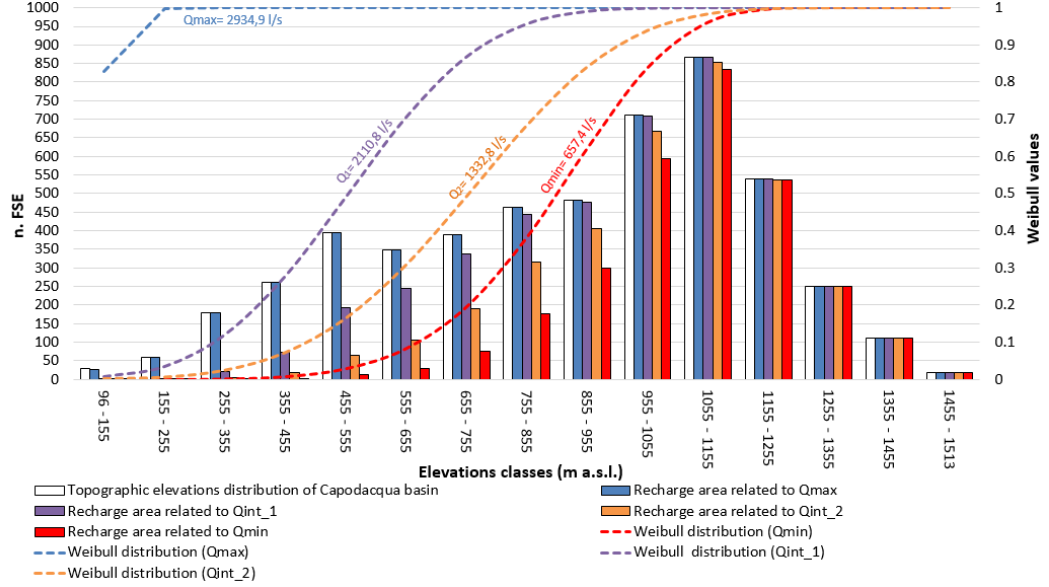
Figure 9. Example of the Weibull-reached area distribution on topographic area distribution for maximum and minimum discharges and the other two intermediate values.